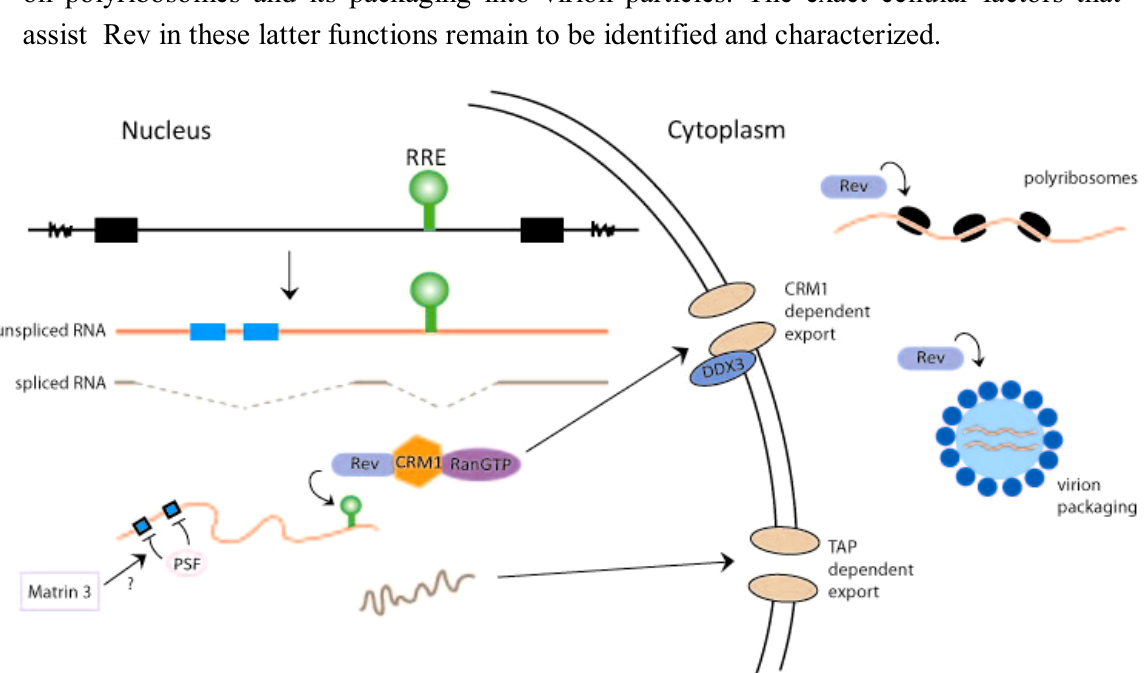
Figure 2. Rev activities influence HIV-1 RNA transport, translation, and packaging. The provirus is shown to produce unspliced RNA (with RRE, green, and instability sequence elements (INS), blue) and fully spliced HIV-1 RNA (with no RRE or INS sequences). The export of unspliced (red)/partially spliced HIV-1 RNA through a CRM1 dependent pathway and the export of fully spliced viral RNA (brown) through a TAP dependent pathway are shown. In the model, negative nuclear factor(s) that binds the INS sequence (e.g., PSF) and participates in the retention of unspliced/partially spliced viral RNAs in the nucleus is illustrated. Rev/CRM1/RanGTP and Matrin 3 are considered to cooperate with DDX3 RNA helicase for the export of unspliced/partially spliced HIV-1 RNAs from the nucleus through the nuclear pores. In the cytoplasm, Rev enhances viral RNA translation on polyribosomes and its packaging into virion particles. The exact cellular factors that assist Rev in these latter functions remain to be identified and